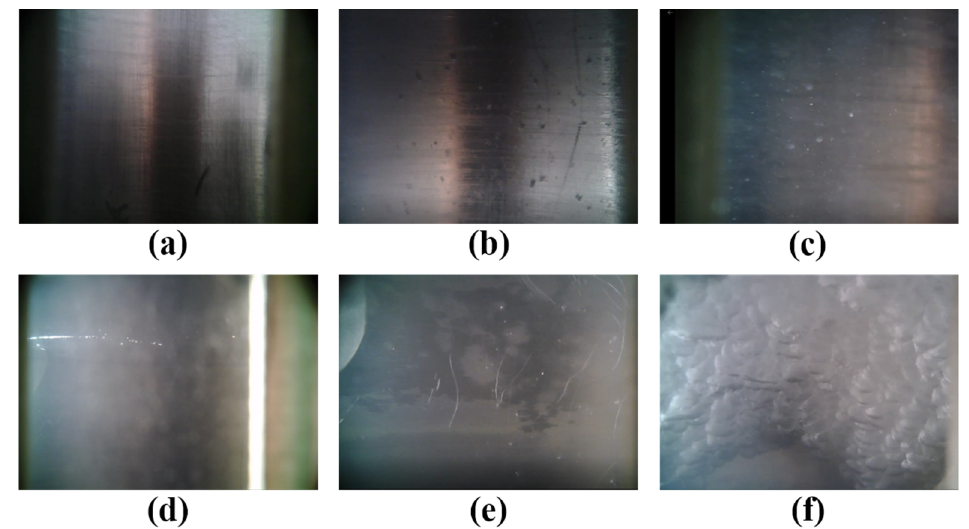
Figure 17. Image recording through built-in camera. ( a ) View inside the USC before CH 4 seeping experiment; ( b ) gas bubbles rising rapidly at 1.67 h; ( c ) CH 4 hydrate particles rising at 22 h; ( d ) hydrate sheet at 26 h; ( e ) flocculent hydrate at 37 h; ( f ) accumulated hydrate bubbles at 100 h.